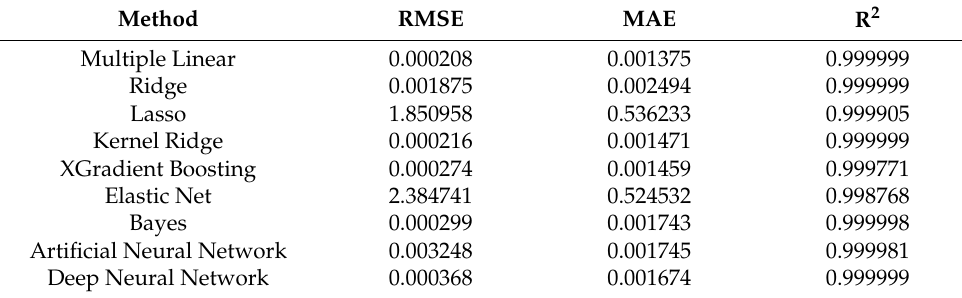
Table 8. Error metric values for fuel consumption